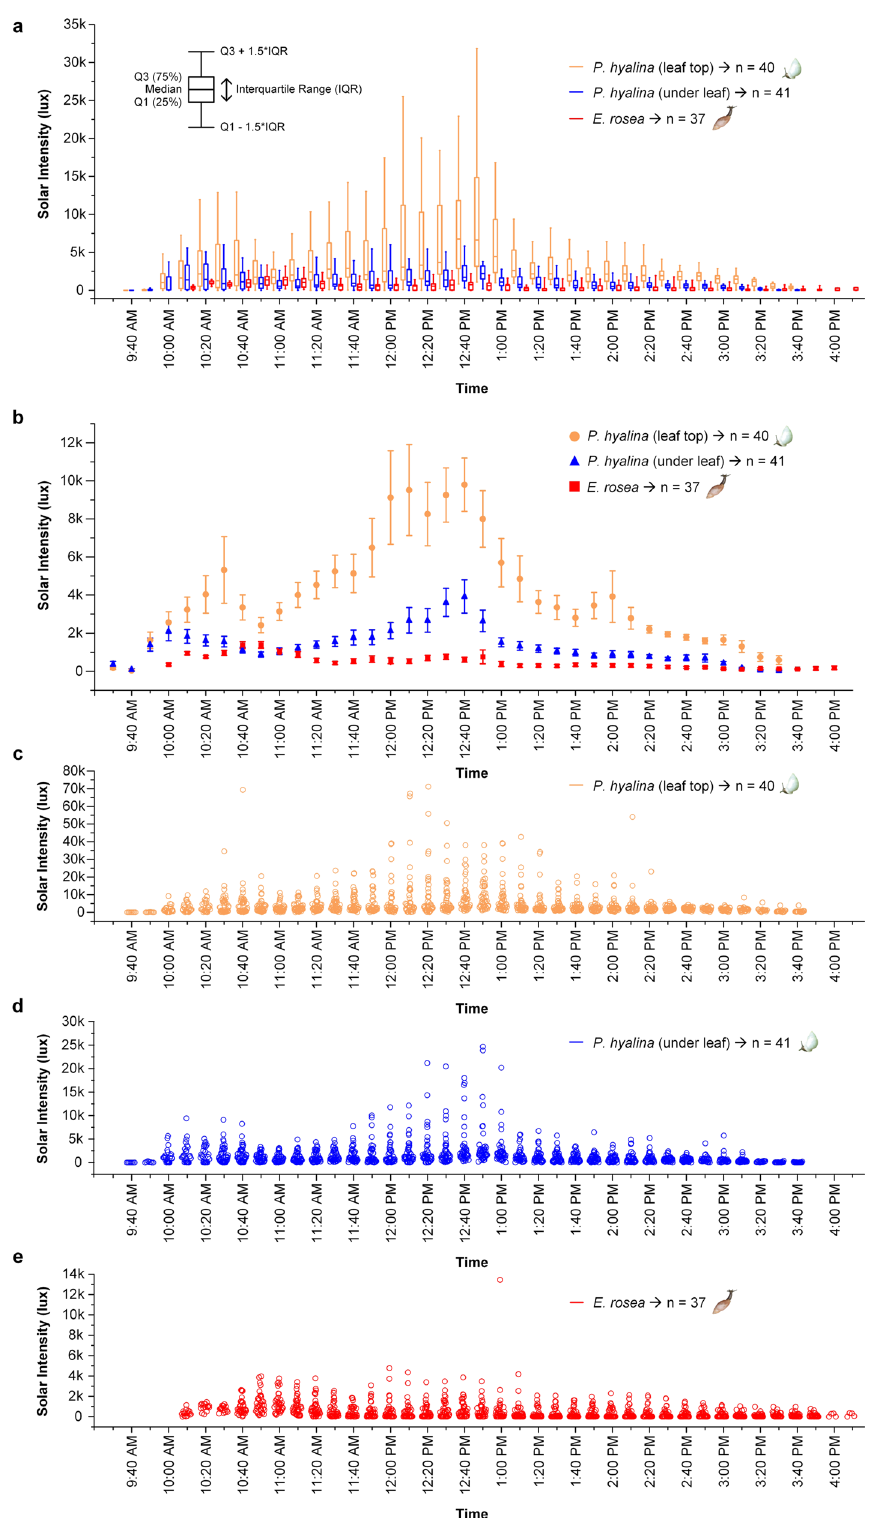
Fig. 3 Tahitian fi eld solar irradiation intensities recorded for the endemic tree snail Partula hyalina and the alien predator Euglandina rosea . Light intensity fi eld data were integrated over 10-min daily time intervals for 37 biologically independent E. rosea specimens (red lines) among two localities over 4 days, and for 41 (leaf top, orange lines) and 40 (under leaf, blue lines) biologically independent aestivating specimens of P. hyalina among three localities over four days. a Boxplot of the recorded light intensities showing median, fi rst quartile (Q1), third quartile (Q3), interquartile range (IQR), 1.5 times the interquartile range above the third quartile (Q3 + 1.5*IQR), and 1.5 times the interquartile range below the fi rst quartile (Q1 − 1.5*IQR) values for each of the three data categories. b mean light intensities and standard errors recorded for each of the three data categories. c All individual leaf top light intensity values (orange circles) recorded for 41 aestivating specimens of P. hyalina . d All individual under-leaf light intensity values (blue circles) recorded for 40 aestivating specimens of P. hyalina . e All individual light intensity values (red circles) recorded for 37 specimens of E. rosea